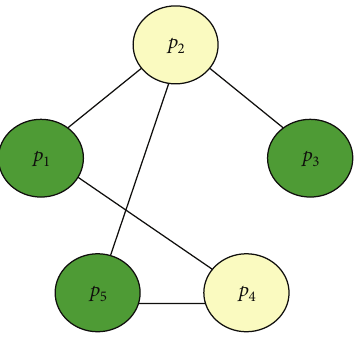
Figure 7: An edge exists between a pair of vertices, if the cor- responding paths cannot coexist. For example, path 𝑝 3 cannot exist together with path 𝑝 2 . Paths belonging to the maximum independent set have been marked green. In this case, the maximum set of paths that can be picked together is equal to 3.